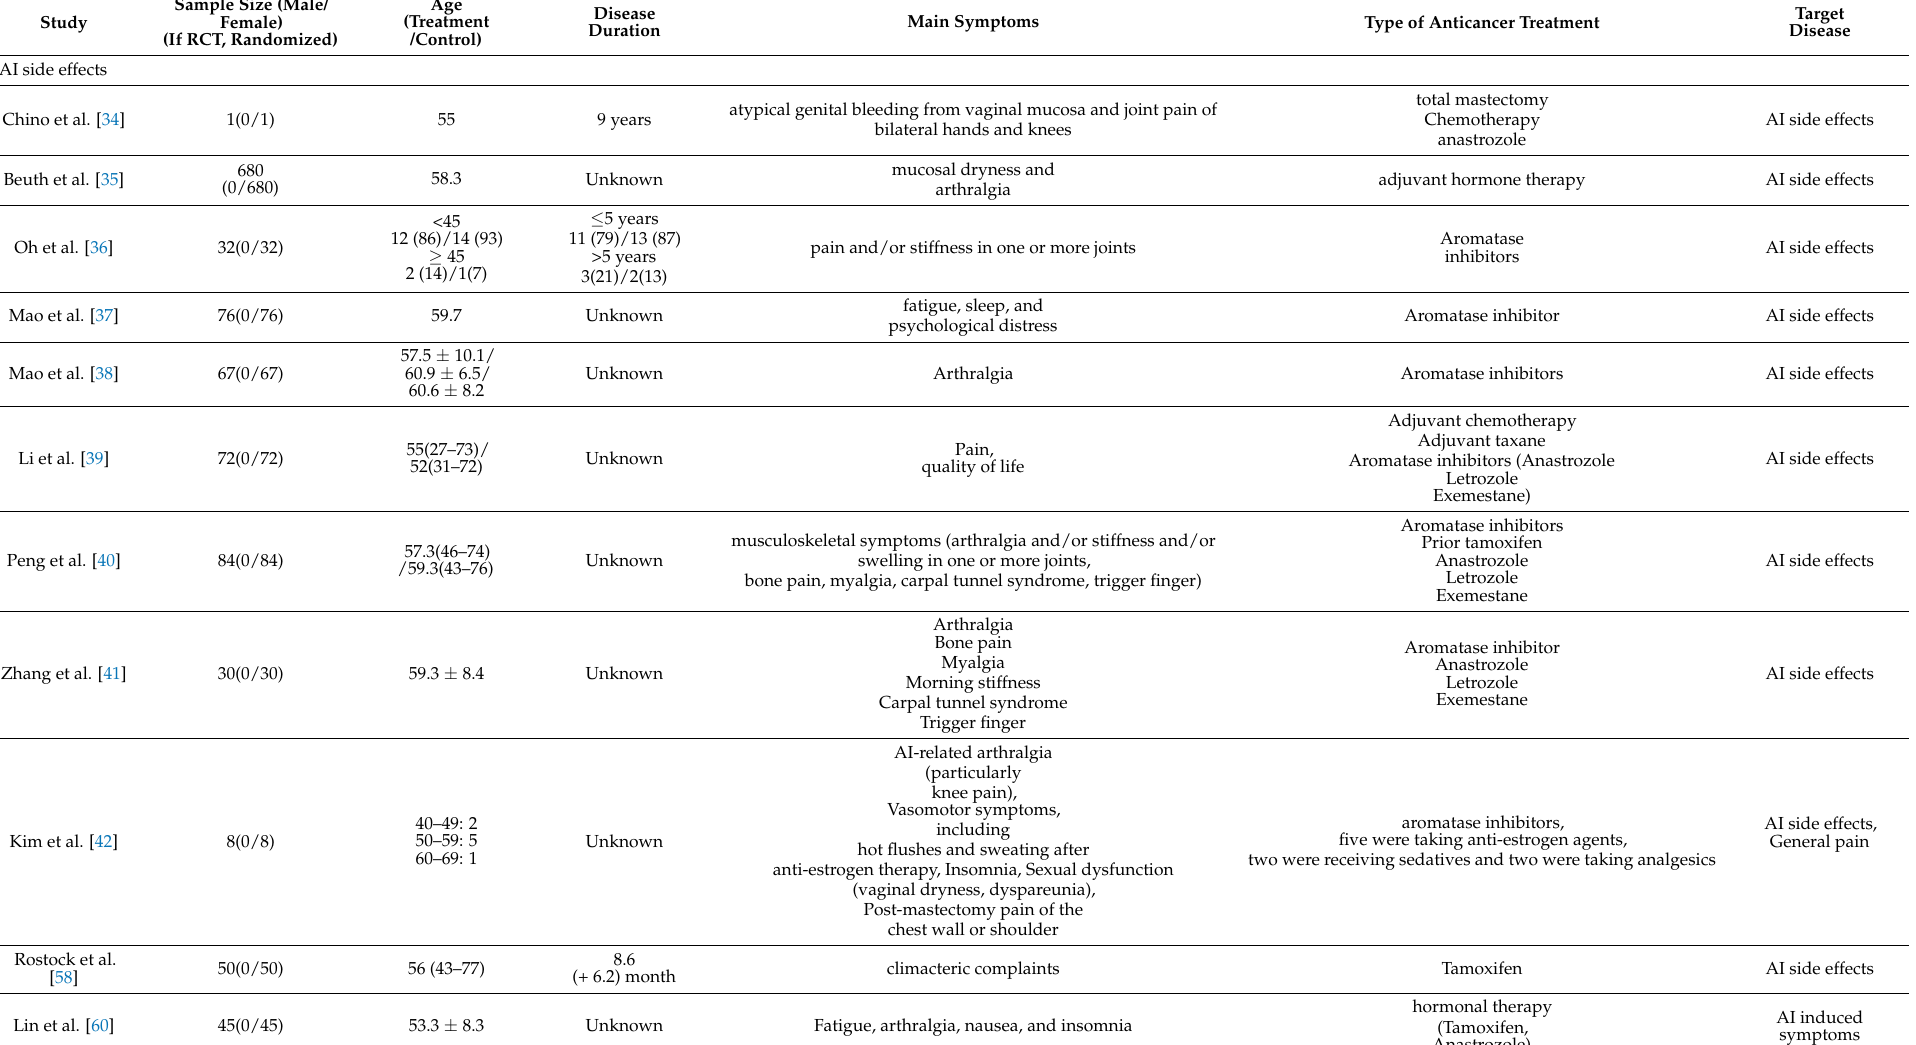
Table 5. Demographic and clinical characteristics of